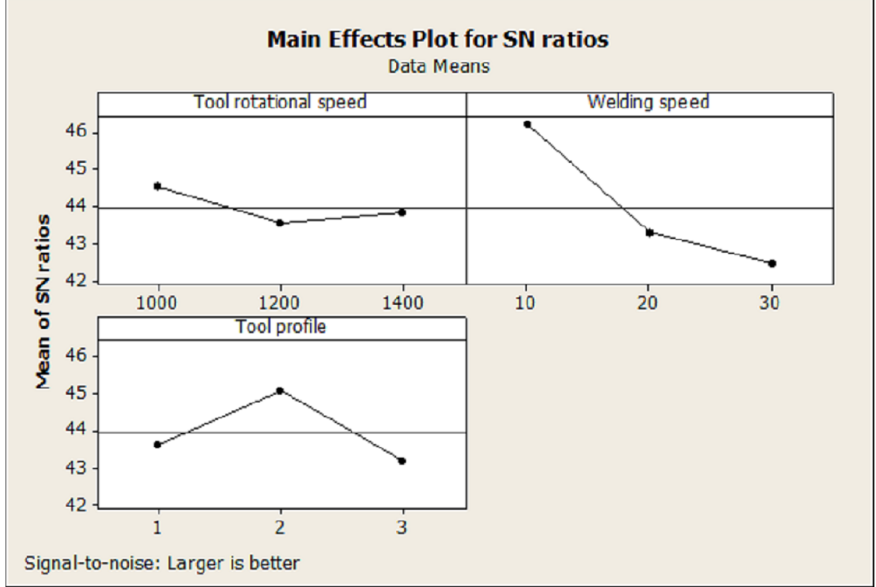
Figure 8. Main effects plot for the S/N ratio for tensile strength.